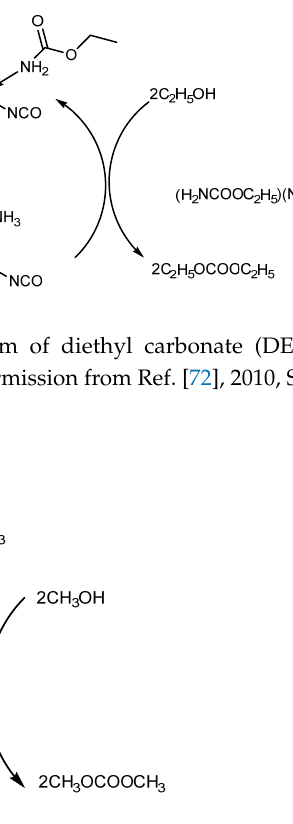
Figure 9. The reaction mechanism for DMC production, as proposed by Wang et al. [73]. (Reprinted with permission from Ref. [73], 2010, Elsevier)